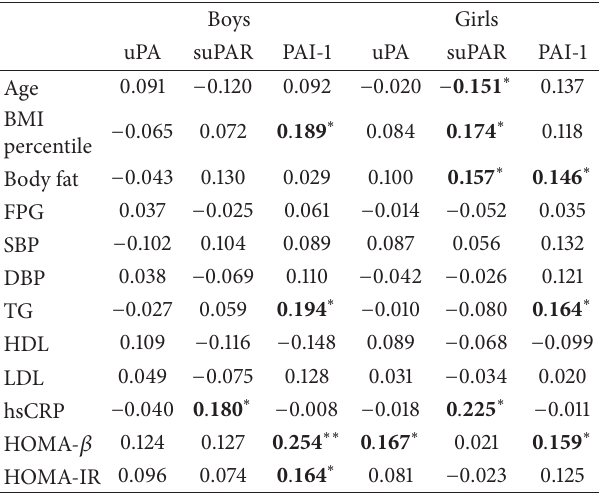
Table 1: Correlation among fibrinolytic proteins, metabolic syn- drome components, and HOMA- 𝛽 and HOMA-IR in boys and